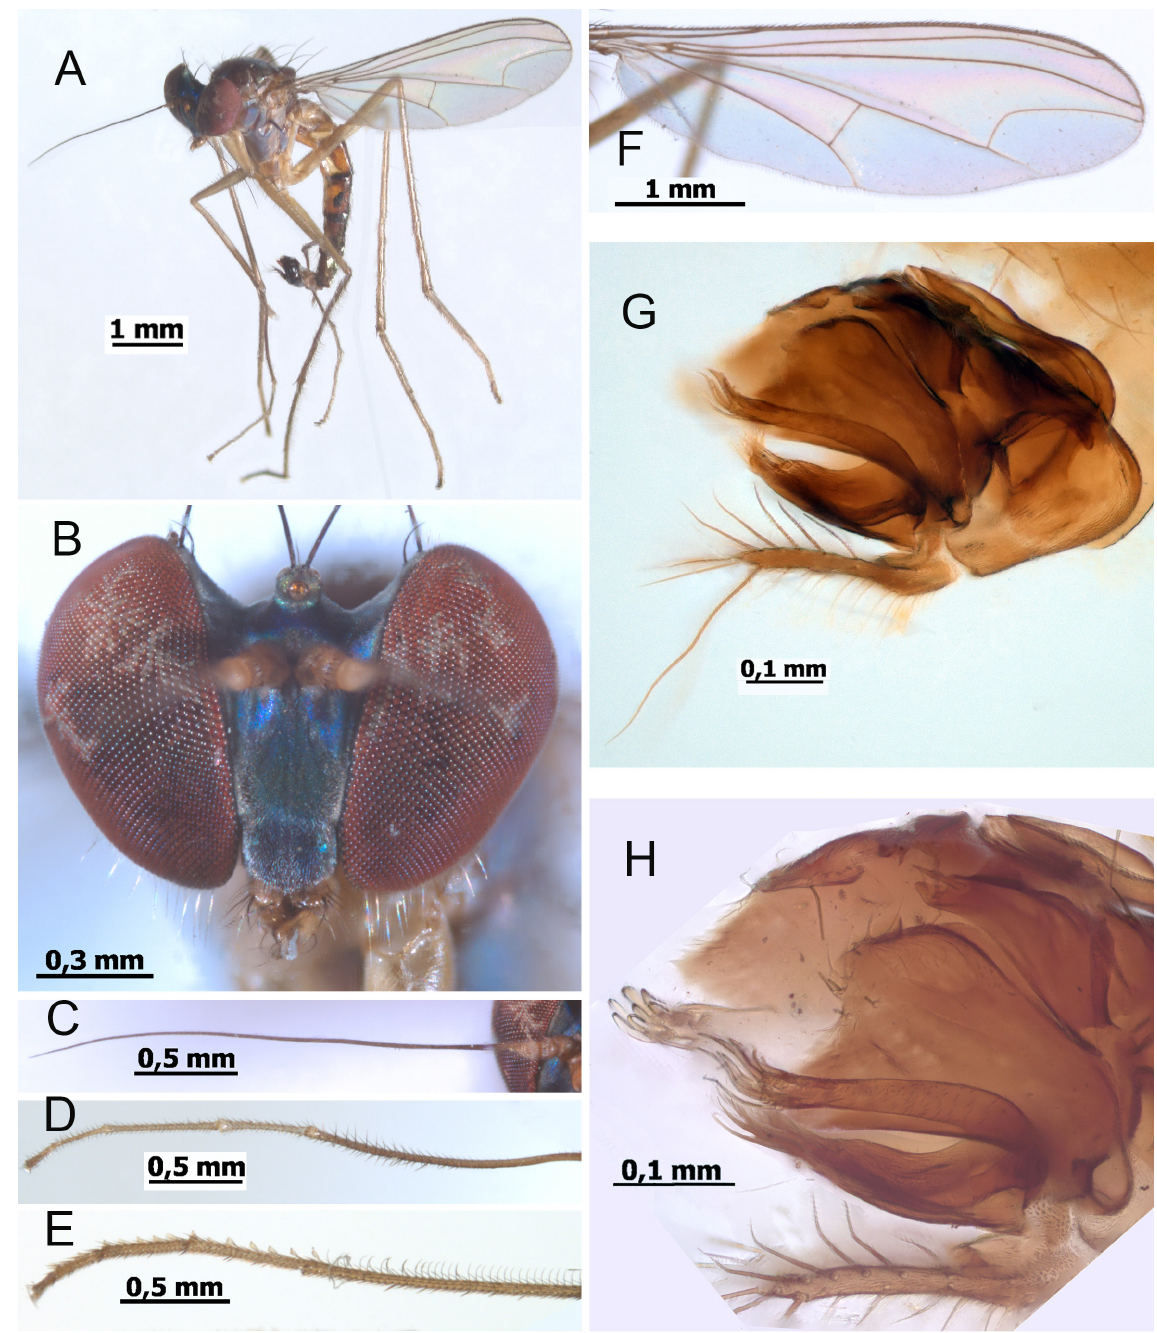
Fig. 5. Amblypsilopus marinae sp. nov. A–F . Holotype, ♂ (SMNHTAU). G–H . Paratype, ♂ (SMNHTAU). A . Habitus. B . Head. C . Antenna. D . Fore tarsus. E . Mid tarsus. F . Wing. G . Hypopygium, left lateral view, reflected light. H . Cercal lobes and surstylus, transmitted